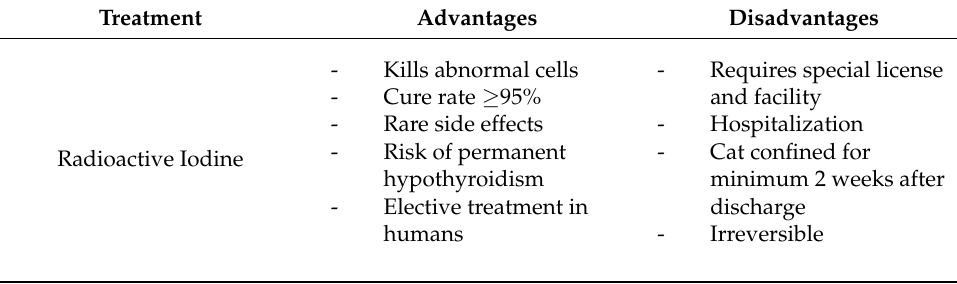
Table 2. Advantages and disadvantages of FHT treatment (modified from